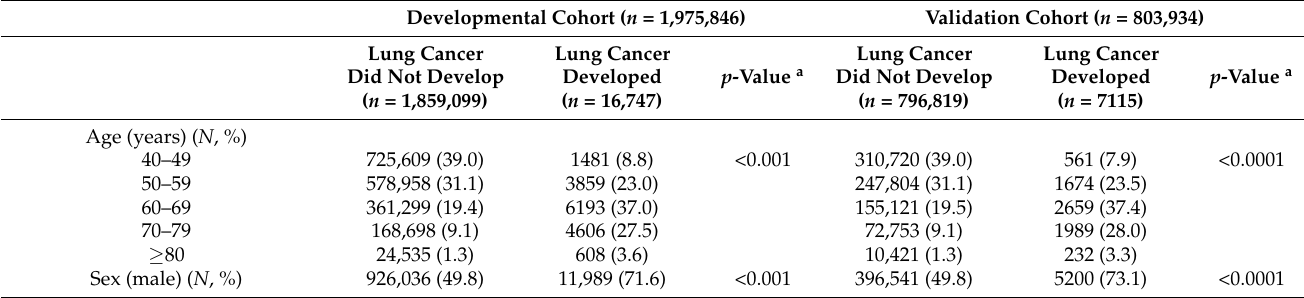
Baseline characteristics of cohort population based on lung cancer incidence in the development and validation